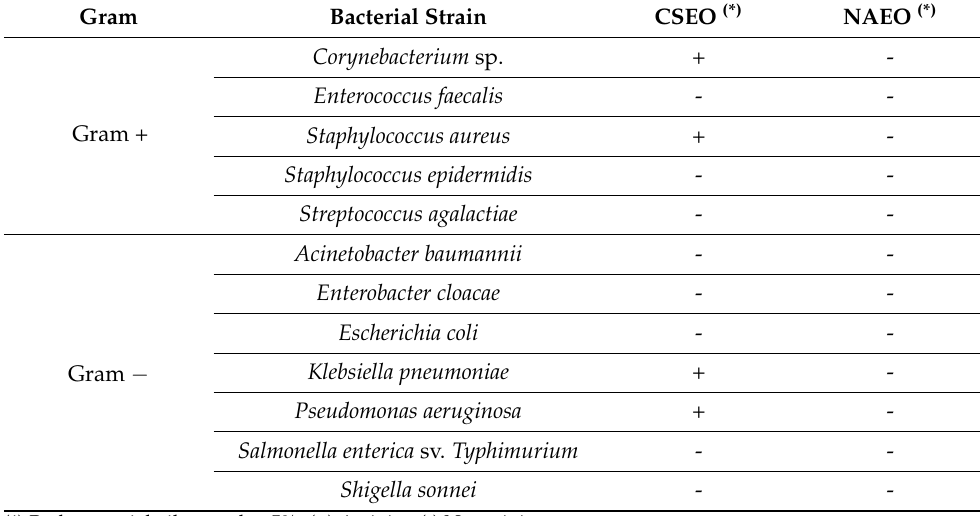
Table 6. Antibacterial activity of the CSEO and